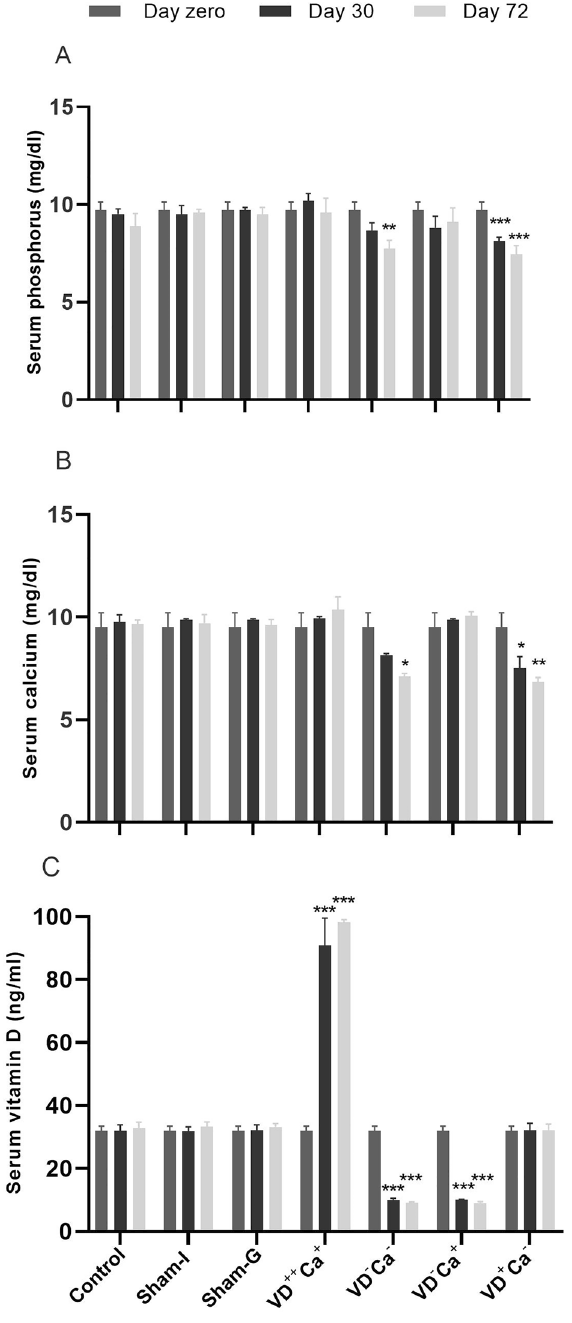
Figure 1. Serum 25-hydroxyvitamin D 2 ( C ) calcium ( B ), and phosphorus ( A ) content at days 0, 30, and 72 in the different groups of mice. * p < 0.05, ** p < 0.001, and *** p <